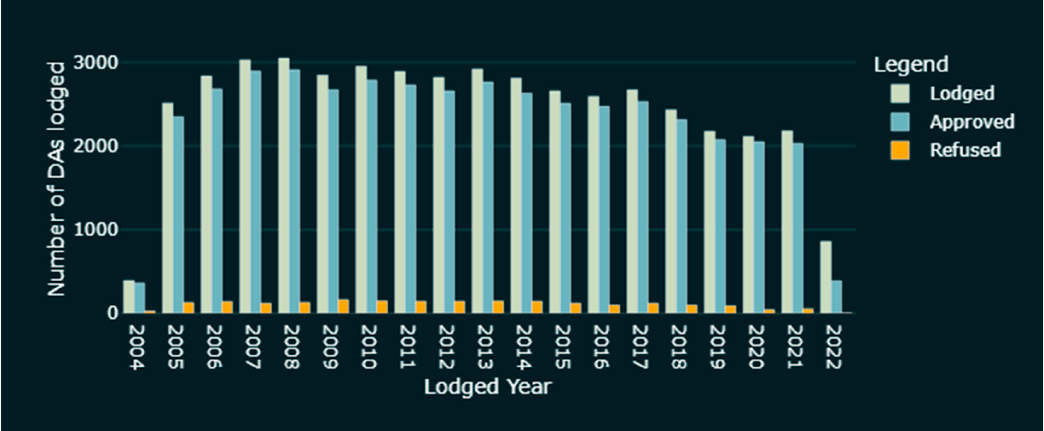
Figure 17. Number of DAs lodged per year and their status distribution (2004–2022).